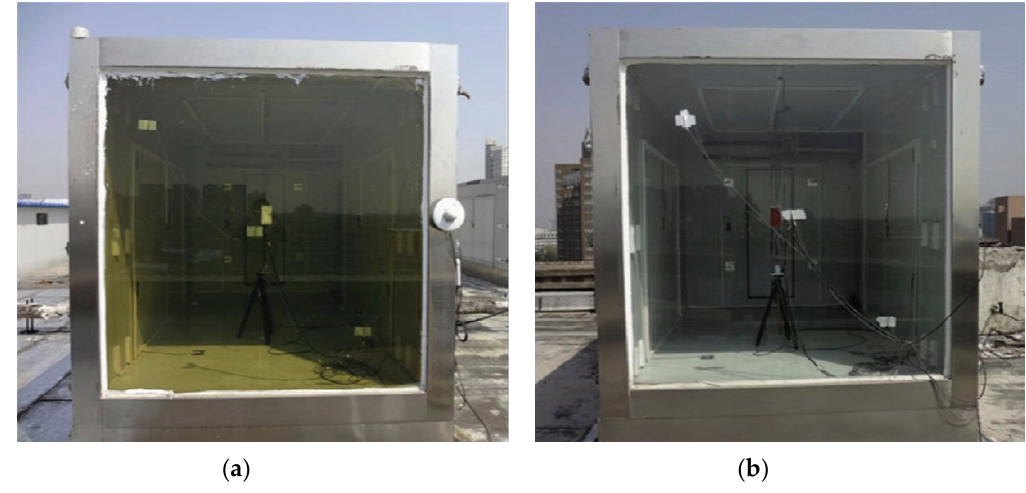
Figure 15. Example windows with thermochromic VO 2 glazing’s ( a ) and ordinary ( b ) [155].